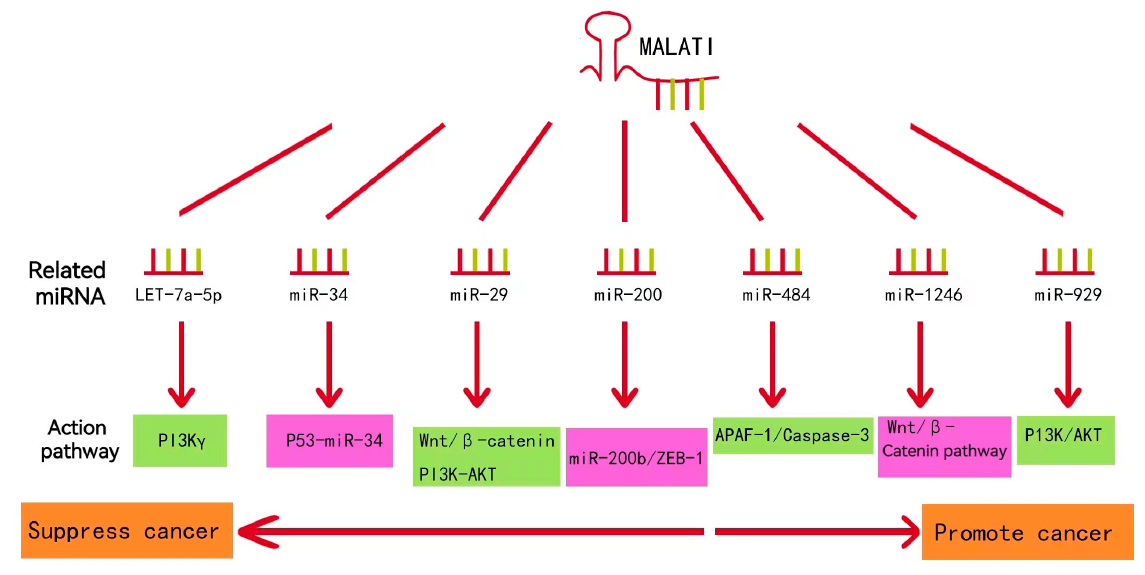
Figure 5. MALAT1-miRNA regulatory pathway associated with lung